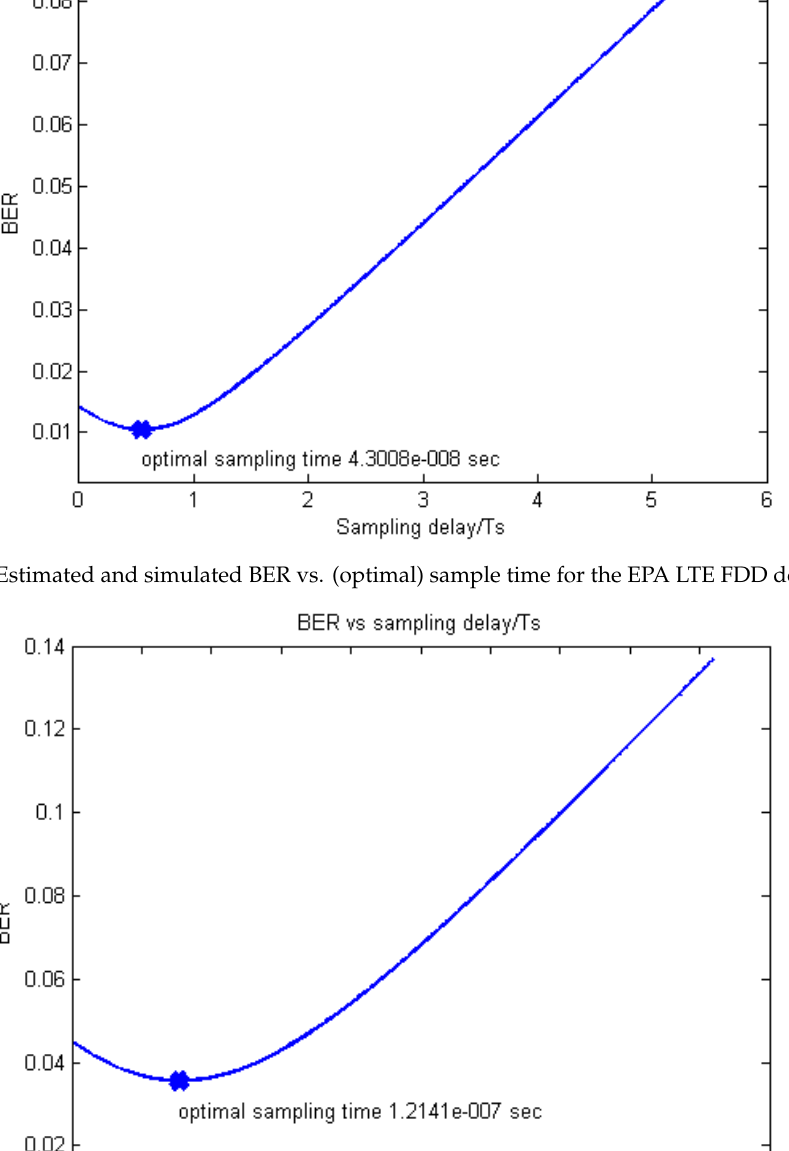
Figure 8. BER floor vs. rms delay spread for 16 QAM modulation for optimal and mean-delay sampling.